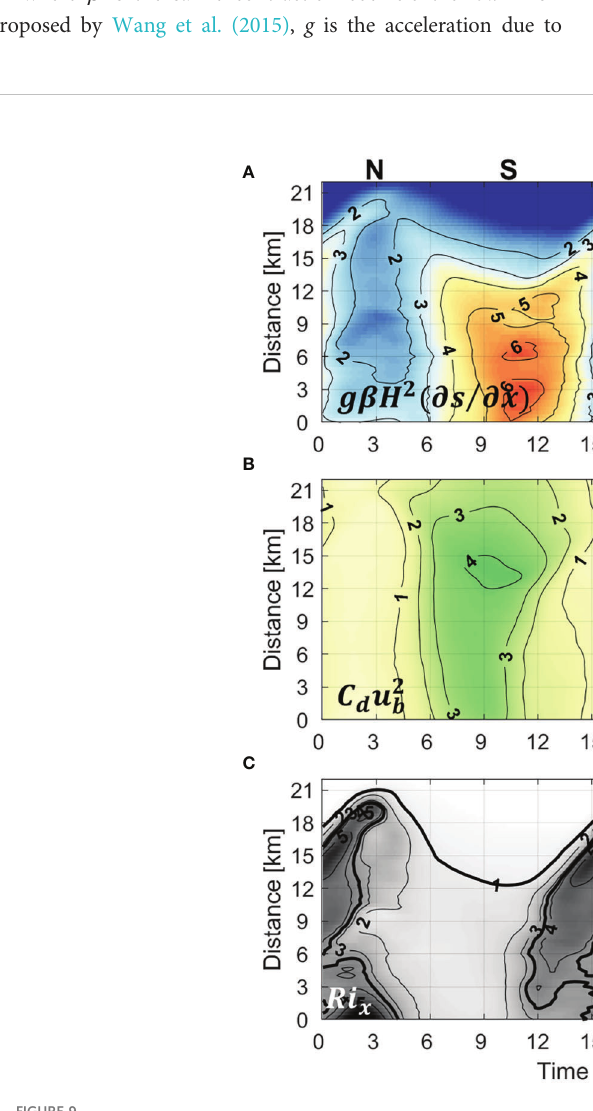
FIGURE 9 Hovmöller diagram of the (A) baroclinic forcing (unit: × 10 4 m 2 s -2 ), (B) bottom stress (unit: × 10 4 m 2 s -2 ), and (C) nondimensional horizontal Richardson